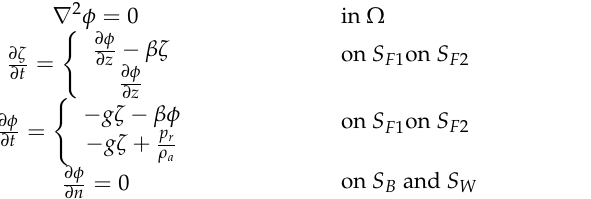
Figure 5. Definition of boundary value problem for wave–chamber–turbine interactions.